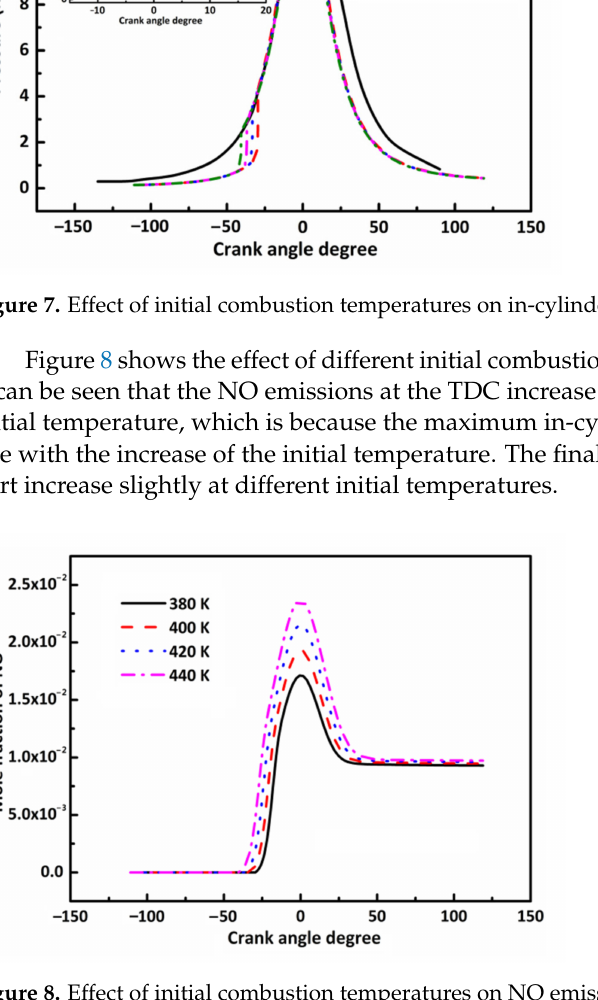
Figure 8. Effect of initial combustion temperatures on NO